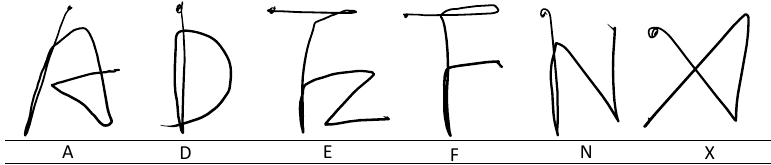
Figure 4. Sample character from 6DMG dataset.